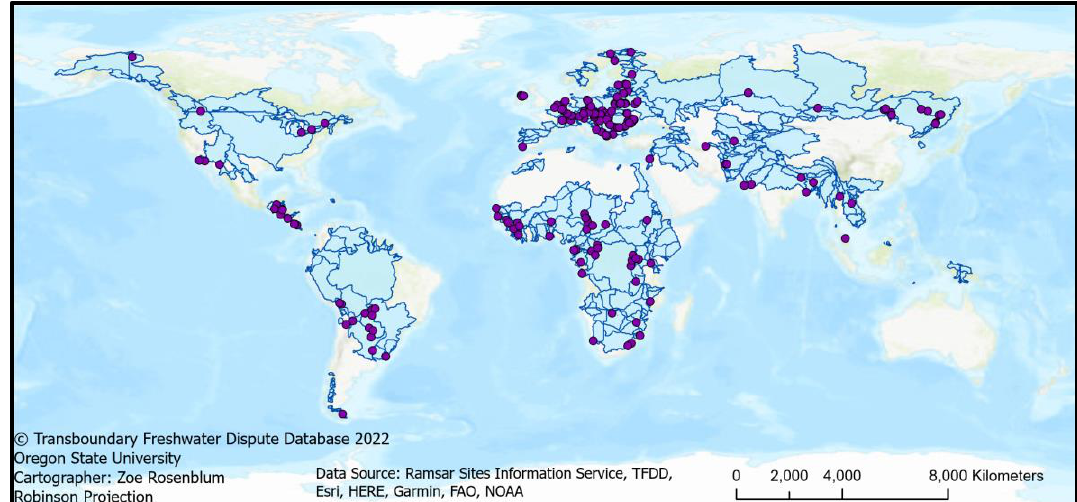
Figure 3. World map with international river basins (in blue shading and outline) and Ramsar Sites that extend onto the territory of one or more other countries (purple points), according to the Ramsar Sites Information Service, Griffin & Ali (2012) [40] and spatial analysis. This map was created in ArcGIS Pro using the data sources in Table 2. The clip tool was used to locate additional wetlands that are situated within international river